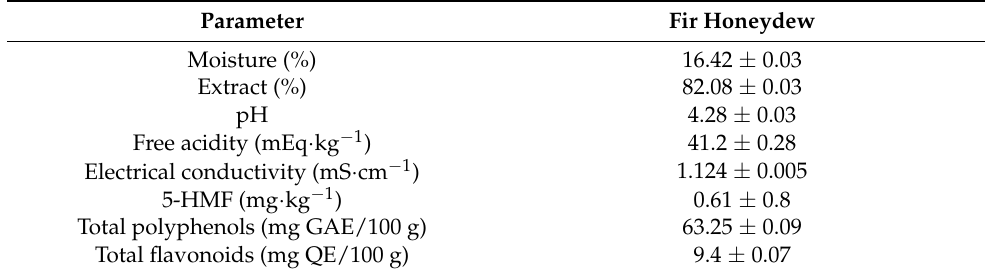
Table 3. Characteristics of physicochemical properties and antioxidant activity of honey (means ± standard